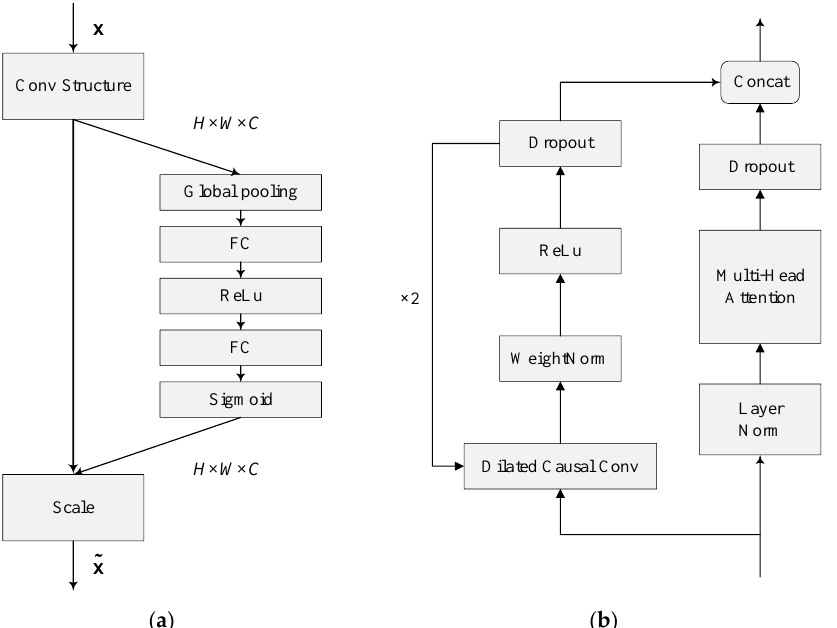
Figure 4. Architecture of SE-Conv and MHSA-TCN. ( a ) SE-Conv; ( b ) MHSA-TCN. The FC-ReLu-FC-Sigmoid layer shown in the figure is the excitation phase and uses a bottleneck structure containing two fully connected layers to reduce the complexity of the model and improve its generalization capability. The role of the fully connected layer is to predict the importance of each channel, obtain the weights of different channels, and apply them to the corresponding channels of the feature map. One of the purposes of using a gating mechanism with Sigmoid as well as ReLu [23] functions is to learn the non- linear as well as nonreciprocal relationships between channels. This process is shown in Equation (4).